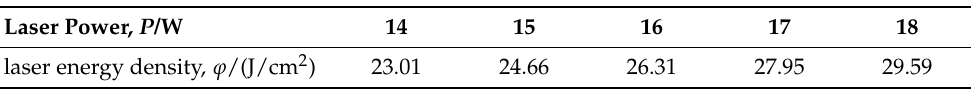
Table 3. The laser energy density corresponding to different laser powers when the repetition frequency is 10 kHz.